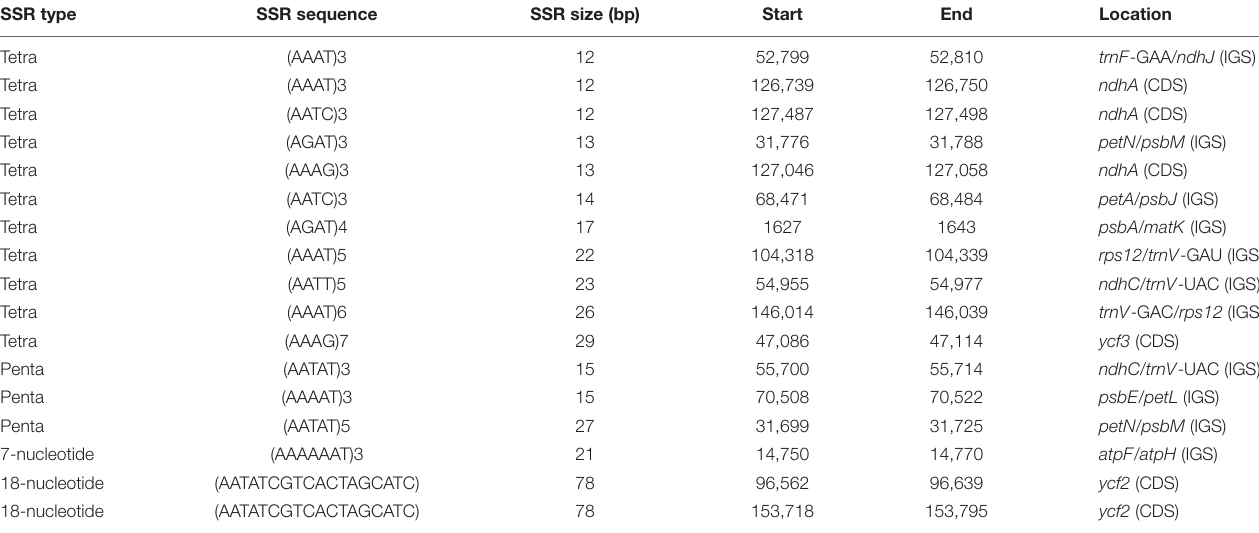
TABLE 4 | Distribution of tetra, penta, and hexapolymer single sequence repeats (SSRs) in Ampelopsis chloroplast genome. SSR type